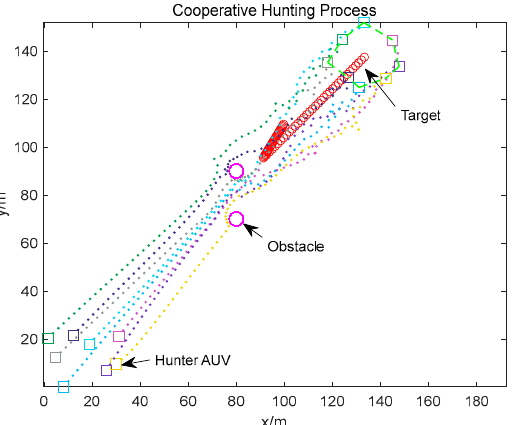
Figure 4. Cooperative hunting process in static obstacle environment based on HAP-IAPF method.